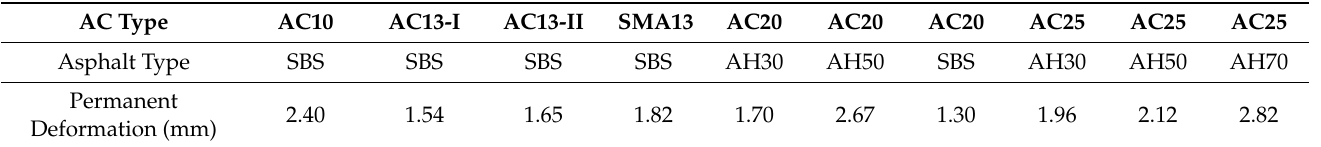
Table 1. Permanent deformation of asphalt mixture rutting